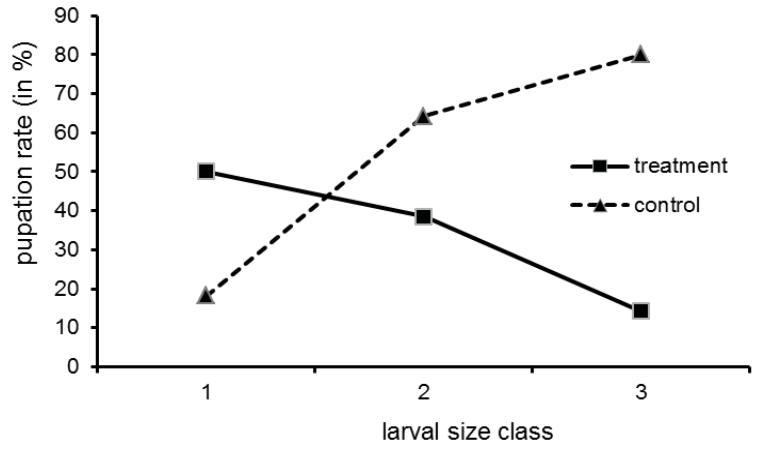
Figure 3. Pupation rate of Macroplea larvae of different size at the beginning of the experiment, after tetracycline treatment and without application of antibiotics (control), respectively. Size classes are defined in the text, sample sizes are given in Table